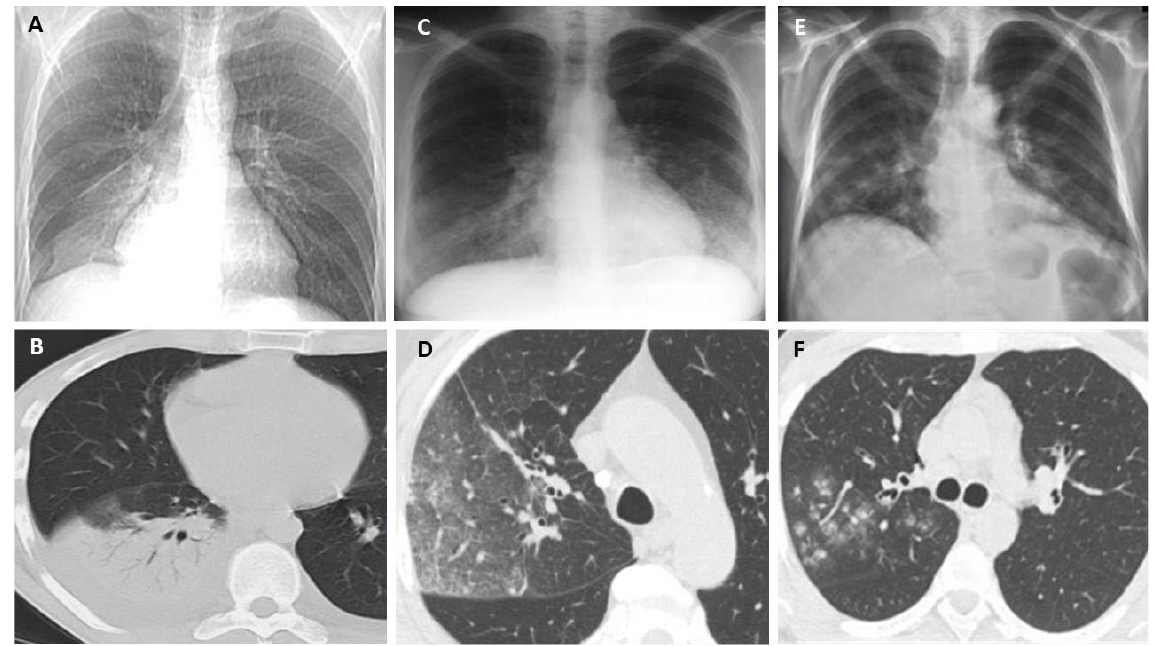
Figure 3. The radiological appearance of bronchopneumonia due to Legionella spp. Types of infiltra- tion: Alveolar type—( A , B ); Interstitial type—( C , D ); Focal type—( E , F ).